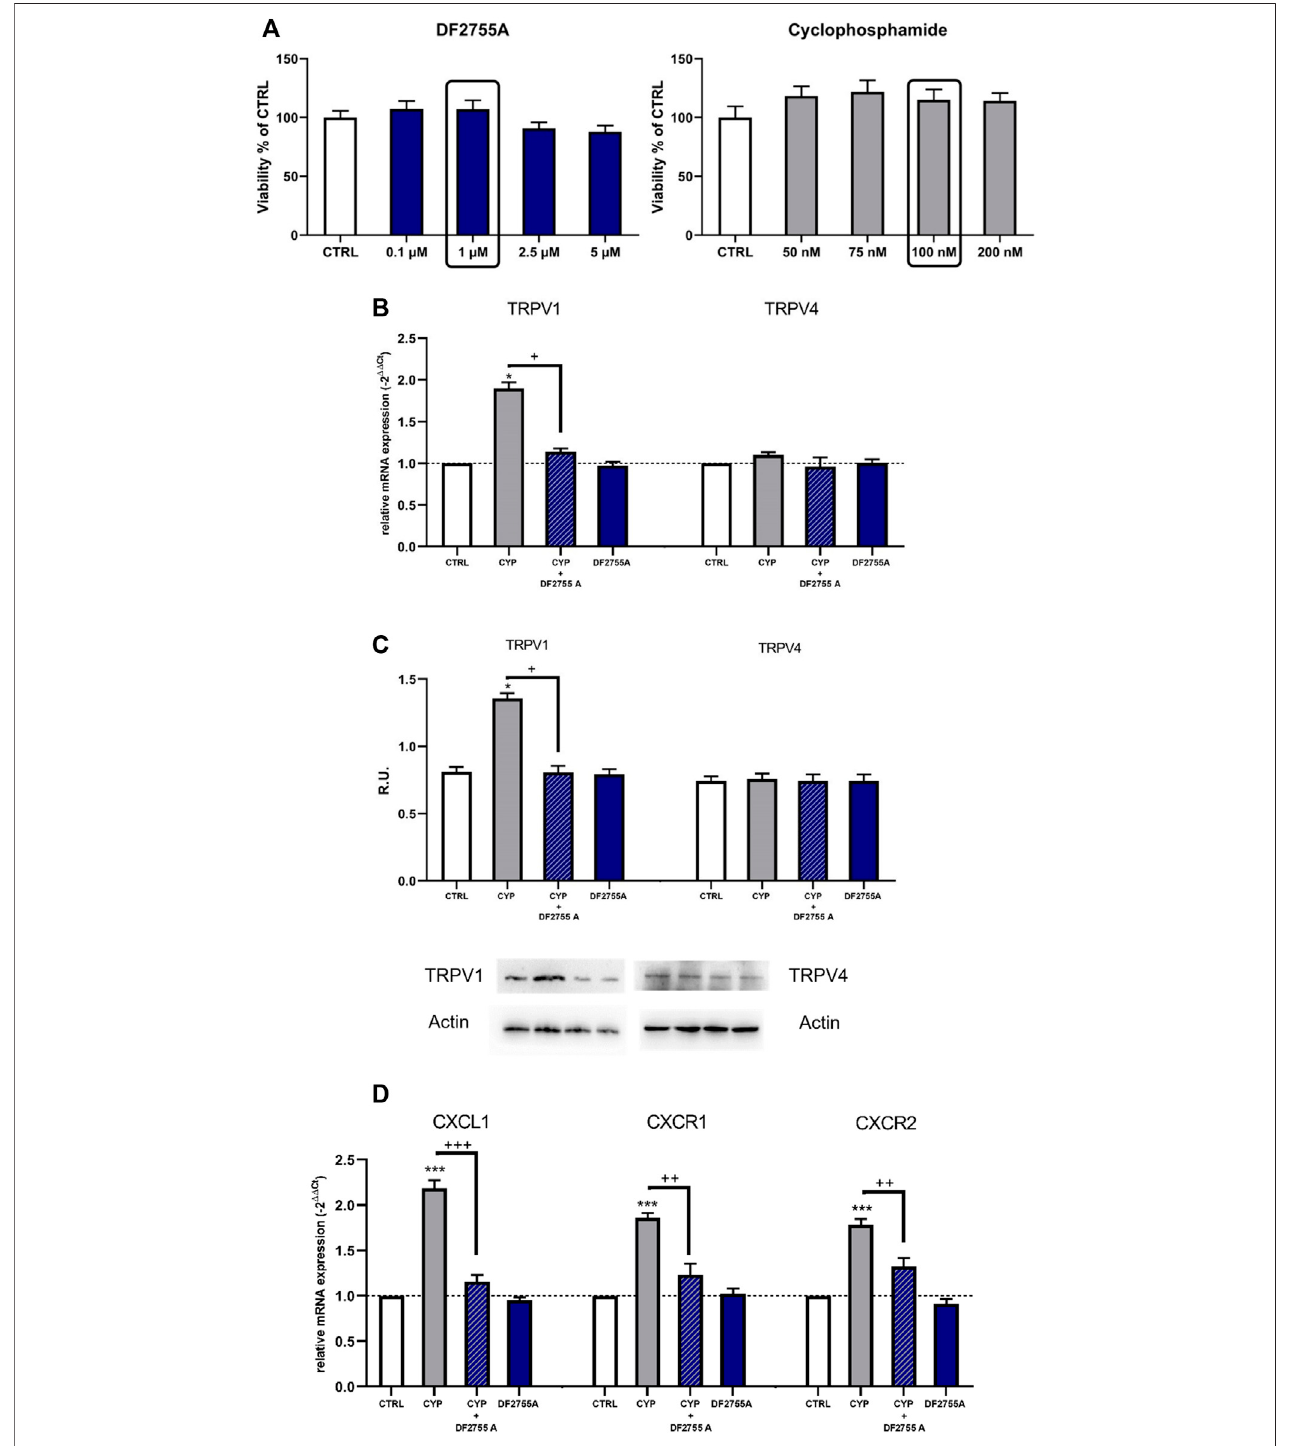
FIGURE 6 | Expression of TRPV1, TRPV4, CXCL1, and its receptors CXCR1/2 upon treatment with CYP, DF2755A, and their combination was evaluated in the F11 cell line. F11 cells were exposed to different concentrations of DF2755A (0.1 – 5 µM) and CYP (50 – 200 nM) (A) ; TRPV1 and TRPV4 expression in F11 cells upon treatmentwithCYP,DF2755A,andtheircombinationwasevaluatedbyRTPCRandWesternblottinganalysisandrelativedensitometricanalysis (B,C) .Arepresentative band is reported (C) . Data are expressed as relative units (R.U.; mean values ± SEM; n = 5 per group). Expression of CXCL1 and its receptors CXCR1/2 was evaluatedbyRTPCRinF11cellsupontreatmentwithCYP,DF2755A, andtheircombination (D) .* p < 0.05and*** p < 0.0001versusCTRLgroup;+ p < 0.05and+++ p < 0.0001 versus CYP group (ANOVA one-way).